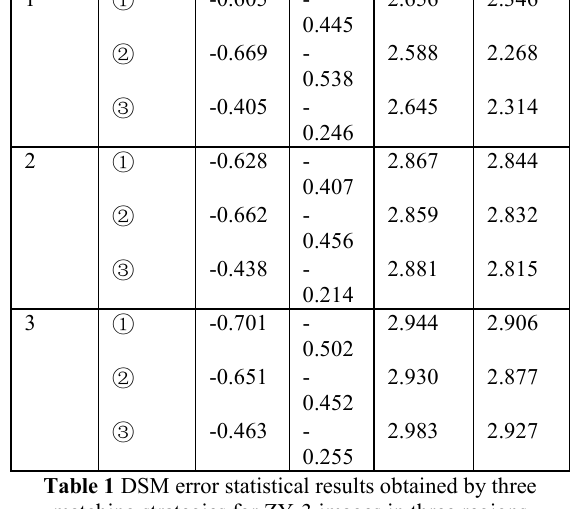
Table 1 DSM error statistical results obtained by three matching strategies for ZY-3 images in three regions